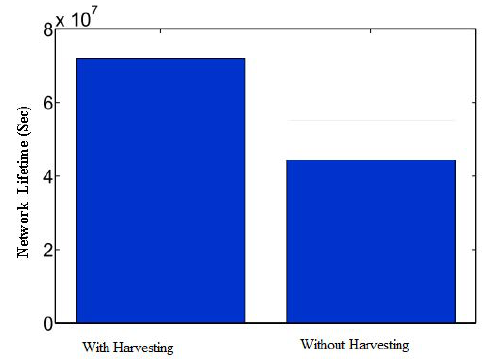
Figure 9. Comparison of hybrid energy harvesting design with and without energy